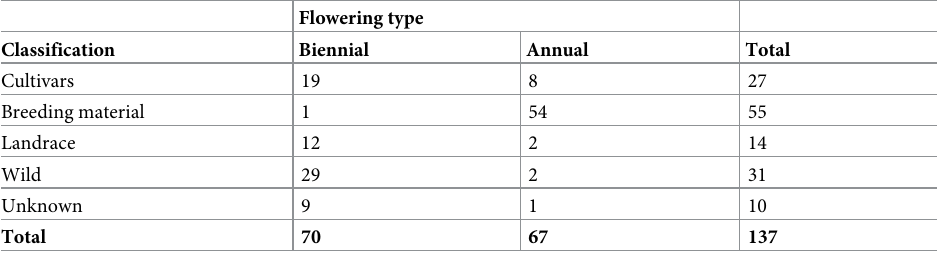
Table 1. Summary of 137 caraway accessions used in this